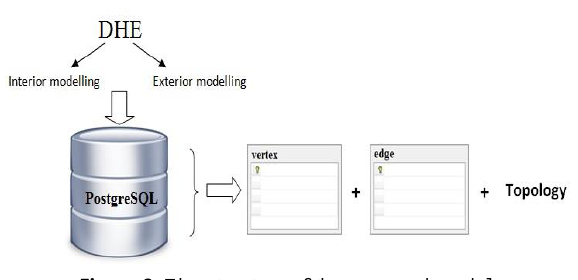
Figure 9 . The structure of the proposed